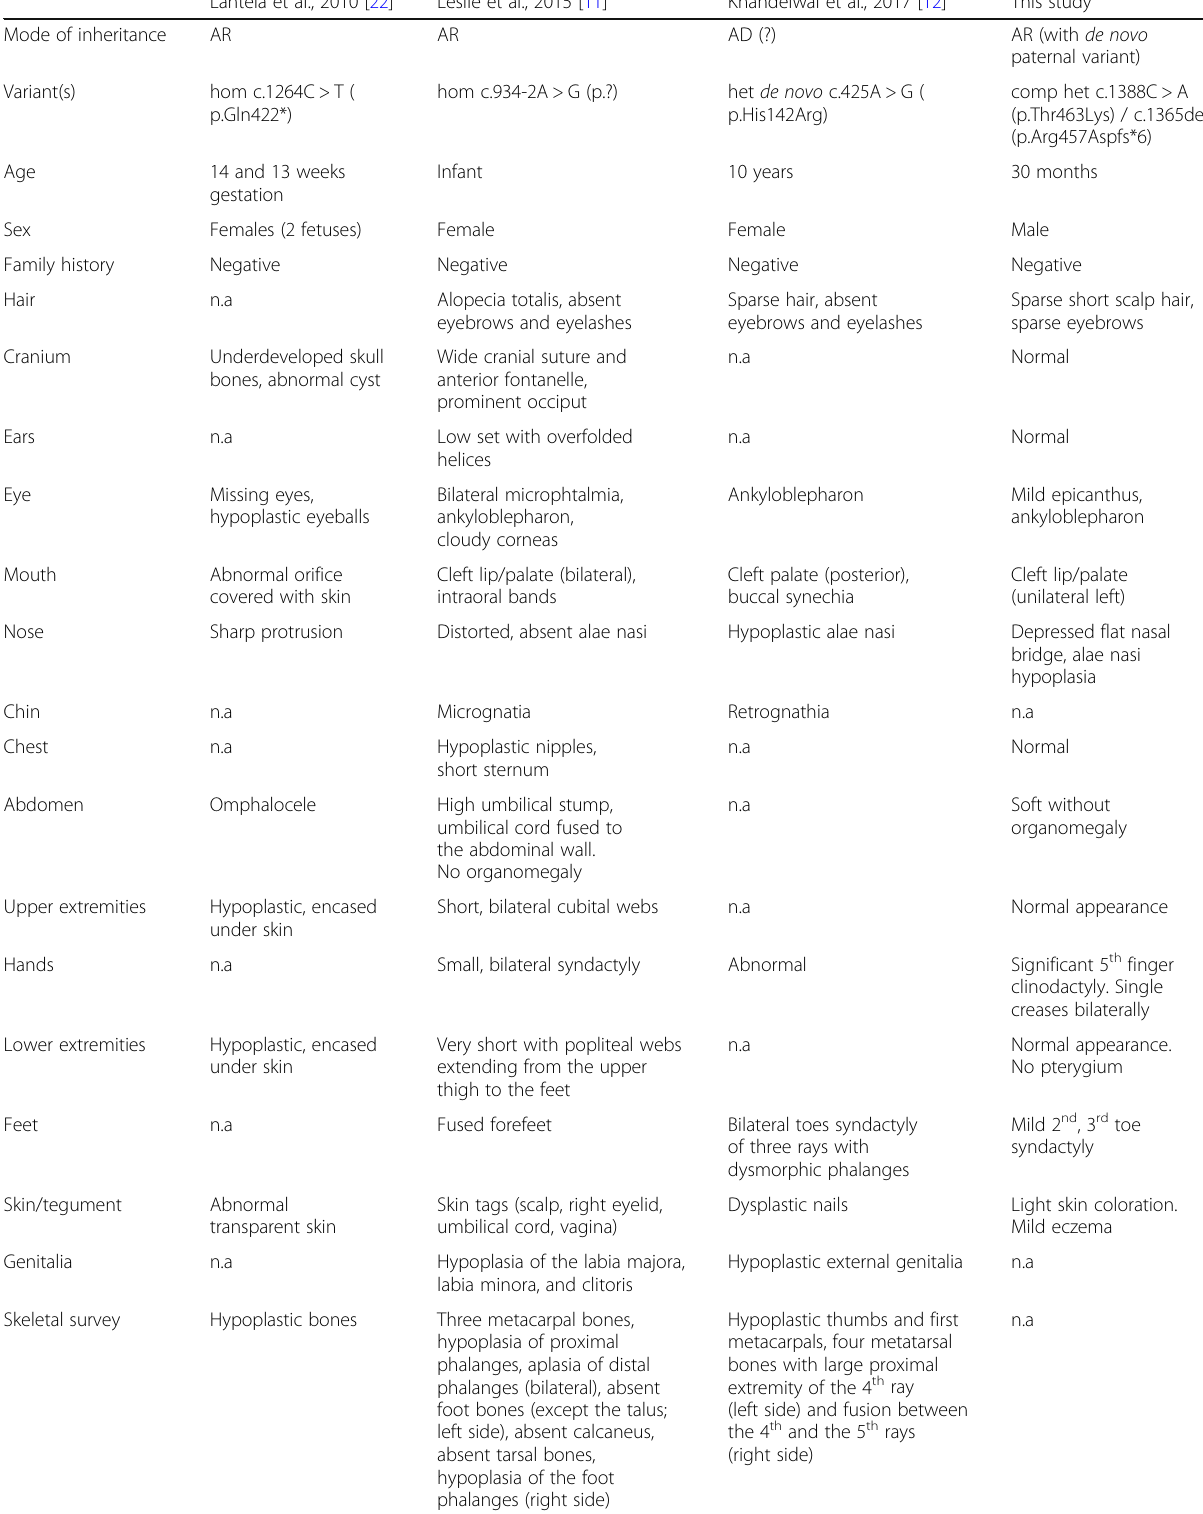
Table 1 Comparison of clinical features of patients with variants in CHUK reported in the literature and in this